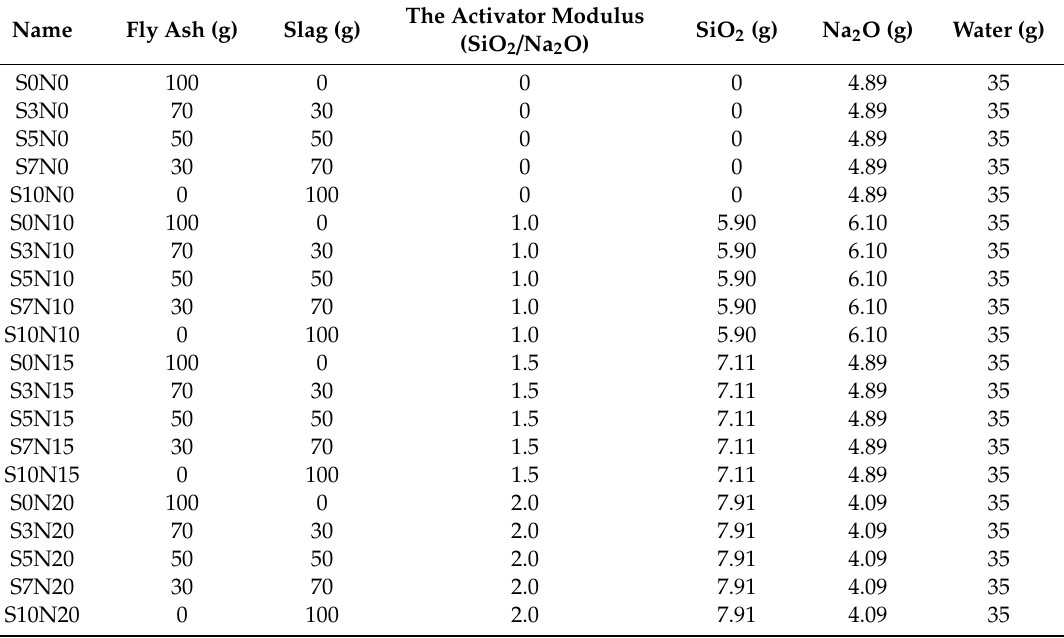
Table 2. Mix composition of fly ash / slag geopolymer